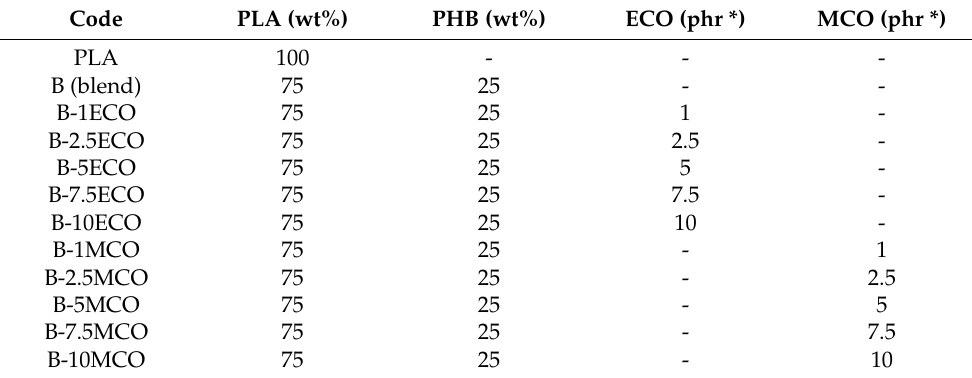
Table 1. Processed